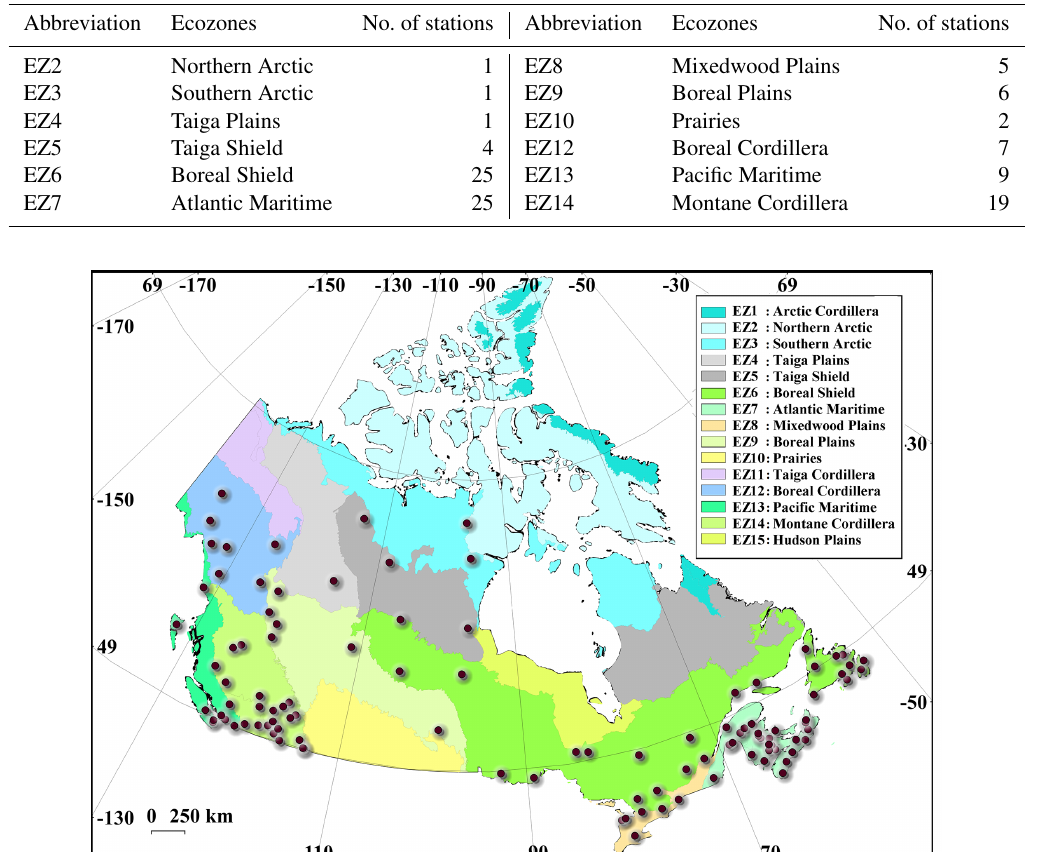
Figure 5. The distribution of the selected 105 RHBN streamflow stations within the Canadian